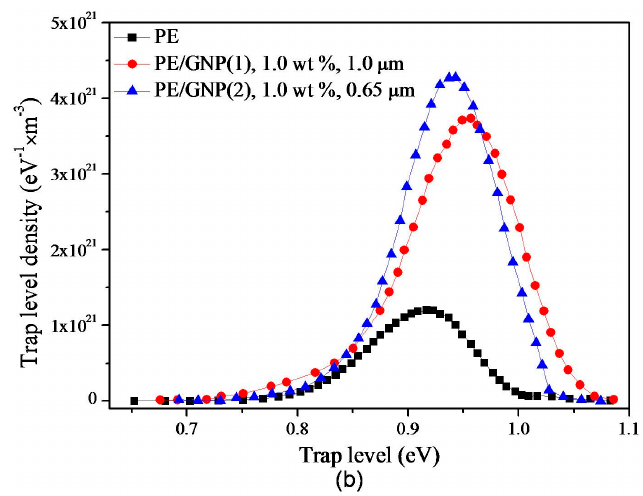
Figure 2. ( a ) Depolarization current versus temperature of pure PE, PE/GNP(1), 1.0 wt %, 1.0 μ m composite, and PE/GNP(2), 1.0 wt %, 0.65 μ m composite; ( b ) Trap level distribution of pure PE, PE/GNP(1), 1.0 wt %, 1.0 μ m composite, and PE/GNP(2), 1.0 wt %, 0.65 μ m composite.